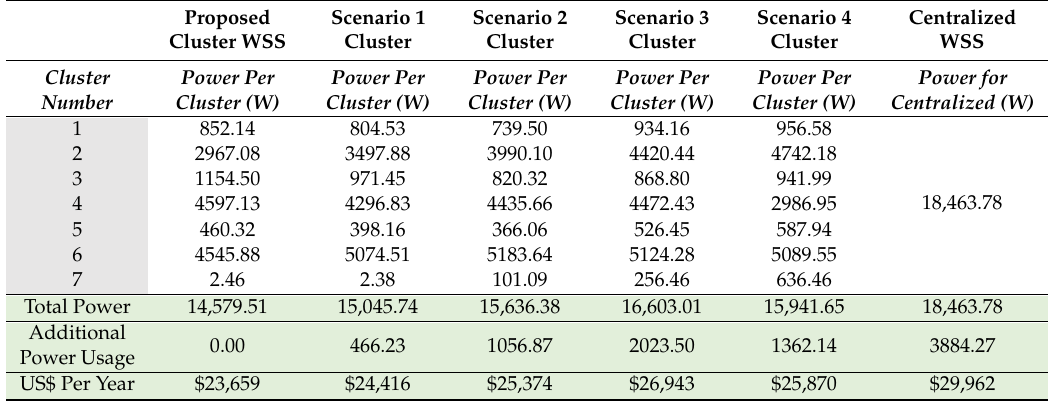
Table 2. Power requirements of each cluster, total power and operational cost per year for every WSS